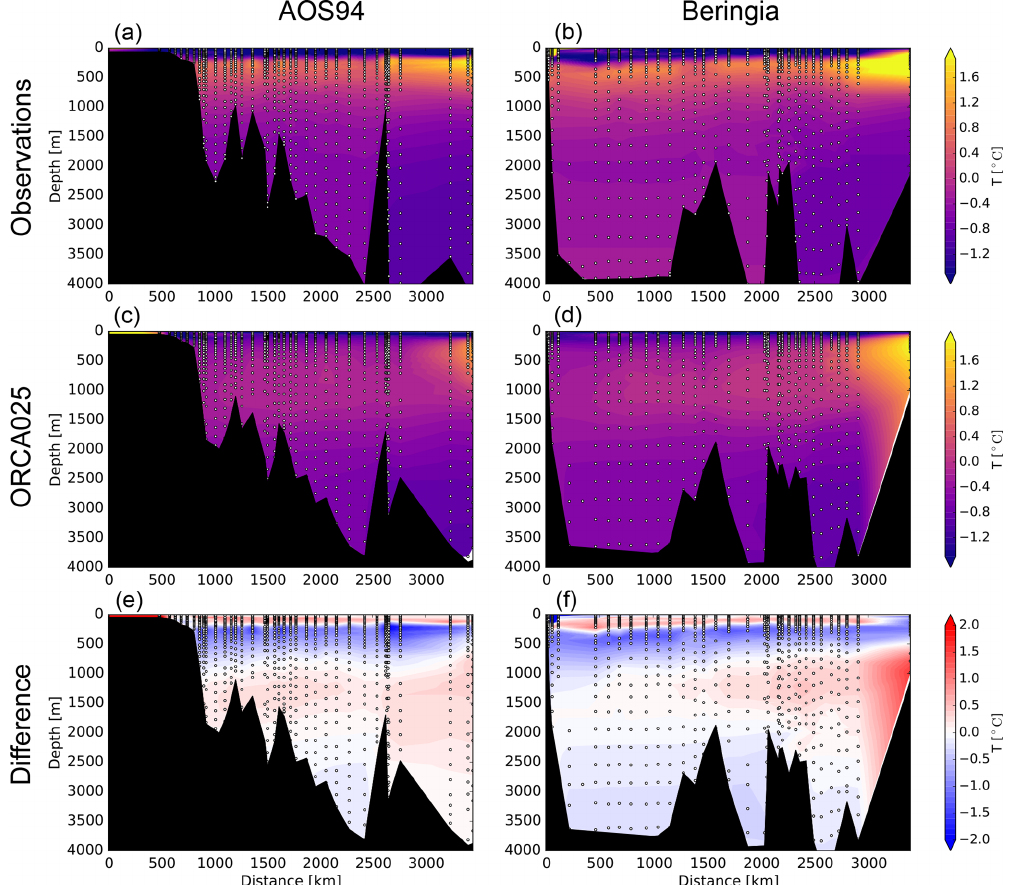
Figure 4. Temperature along the 1994 Arctic Ocean Section (AOS94) cruise (a, c, e) and the Beringia 2005 section (b, d, f) , both trans-Arctic transects (Fig. 1). The observations (a, b) are compared to simulated results from ORCA025 averaged over the summer of the respective year (c, d) . The model–data difference is shown at the